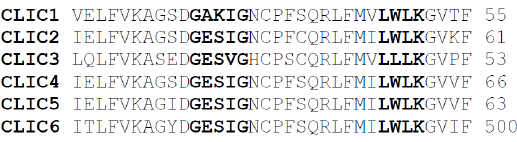
Figure 3. Amino Acid Sequence Alignment of Human CLIC proteins showing the CRAC motif. Highlighted in red is the GXXXG motif and in Green highlighted the LWLK motif in human CLICs. CLIC1 (accession number: CAG46868.1), CLIC2 (accession number: CAA03948.1), CLIC3 (accession number: NP_004660.2), CLIC4 (accession number: CAG38532.1), CLIC5 (accession number: AAF66928.1), CLIC6 (accession number: NP_444507.1). The alignment was produced using